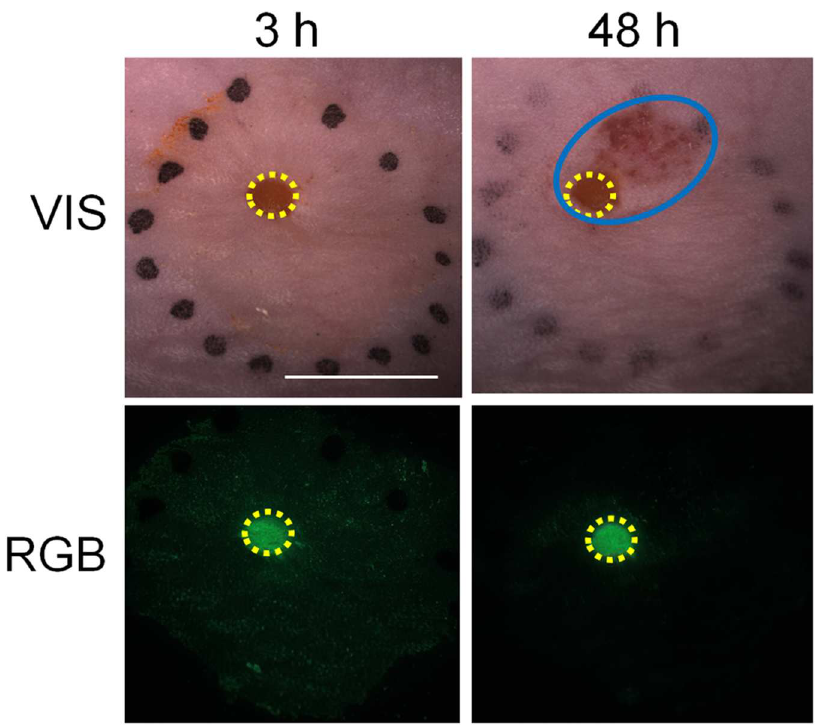
Fig 1. Microscope images of the direct and indirect skin damage caused by plasma jet treatment. Images were taken under stereomicroscope at 3 h and 48 h post-treatment. The direct and indirect damage can be observed under visiblelight (VIS). FITC labelleddextran was observedunder RGB conditions and was ascribedas an indicatorof direct skin damage.Yellow circles represent the direct skin damage;the indirect damageis labelledin blue. Scale bar : 5